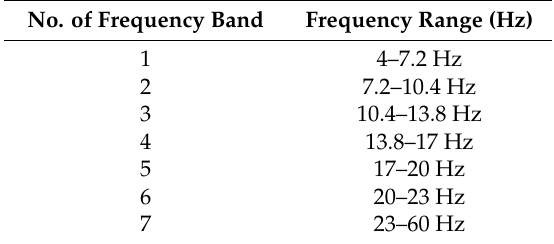
Table 1. Frequency band ranges of recorded EEG